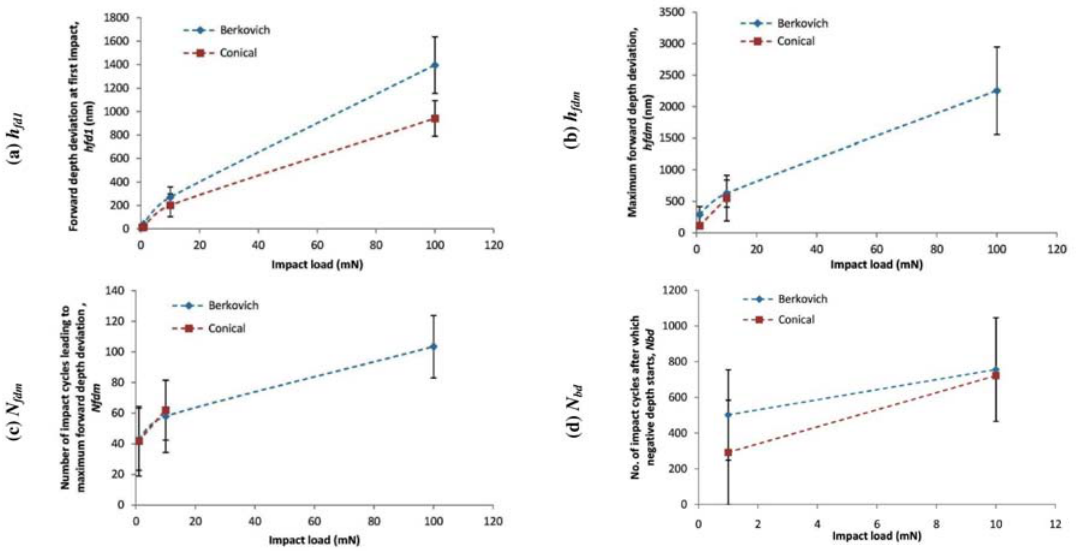
Figure 7. Nano-impact test response: ( a ) Forward depth deviation at first impact cycle, h . ( b ) Maximum forward depth deviation, h . ( c ) Number of impact cycle at the fd1 fdm maximum forward depth deviation, N . ( d ) Number impact cycles after which negative fdm depth starts, N . bd